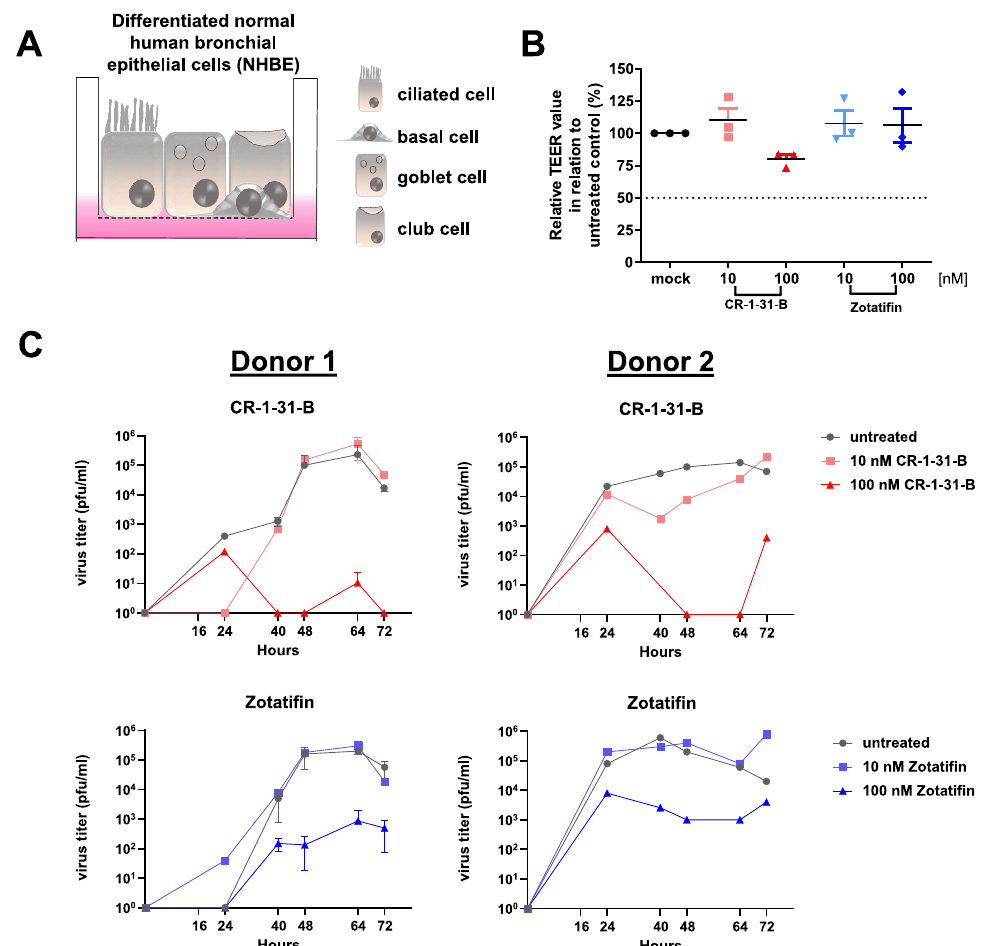
Figure 6. Comparison of antiviral effects of CR-1-31-B and zotatifin using human bronchial epithelial cells infected with MERS-CoV. ( A ) Human bronchial epithelial cells were cultivated and differentiated under the air–liquid interface into different airway epithelial cell types (basal, ciliated, club and goblet cells) and used to assess antiviral effects of the respective compounds. ( B ) Trans-epithelial electrical resistance (TEER) measurement of NHBE cells treated for 72 h with the indicated compounds. ( C ) MERS-CoV titers of infected NHBE cells from two different donors collected at the indicated time points p.i. and treated with CR-1-31-B or zotatifin (each at 10 and 100 nM) in comparison with the solvent